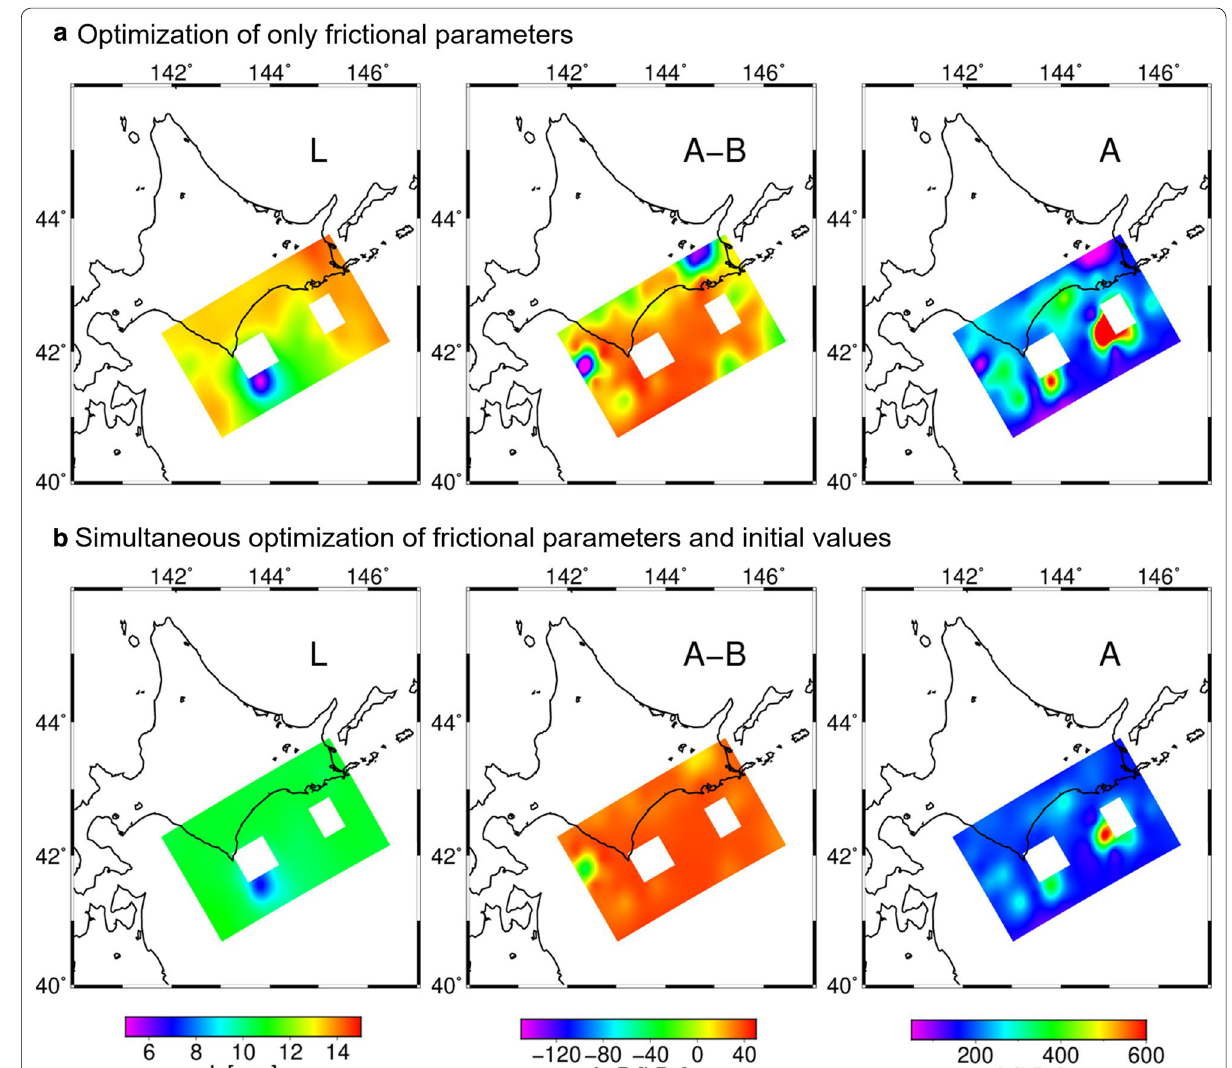
Fig. 9 Spatial distributions of the optimized frictional parameters. Only frictional parameters are optimized in a , while in b , the initial values of the simulation variables and frictional parameters are simultaneously